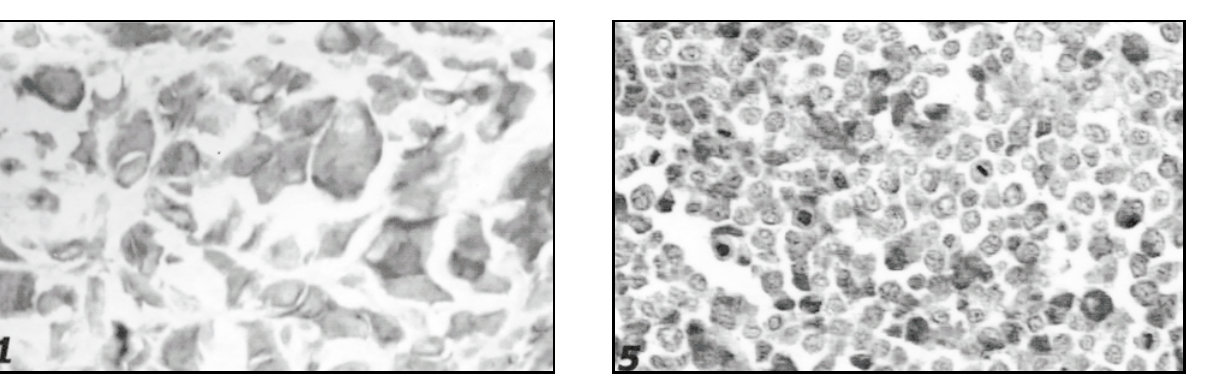
Figure 1 – Mesothelioma, anti-vimentin, cytoplasm stainig (x 1.000) Figure 5 – Seminoma, anti-placental alkaline phosphatase (PLAP), cytoplasm staining (x 800)